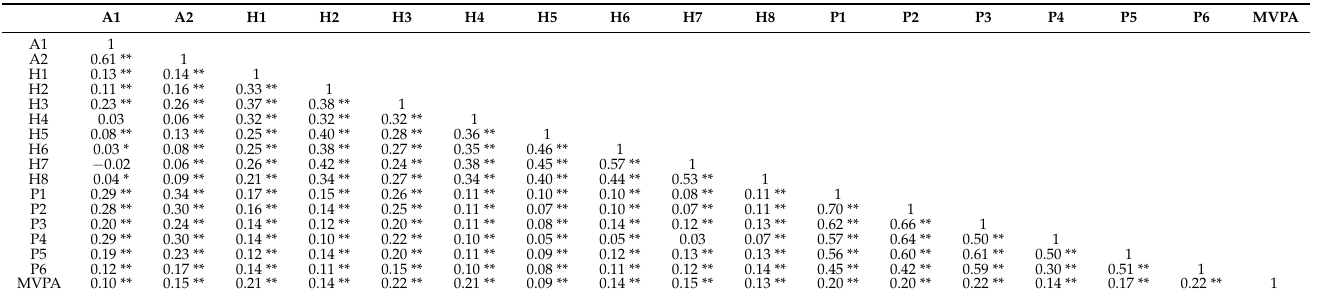
Table 1. Correlation between the factors of parental support, availability of physical activity resources in the home environment and autonomous motivation and moderate to vigorous physical activity.